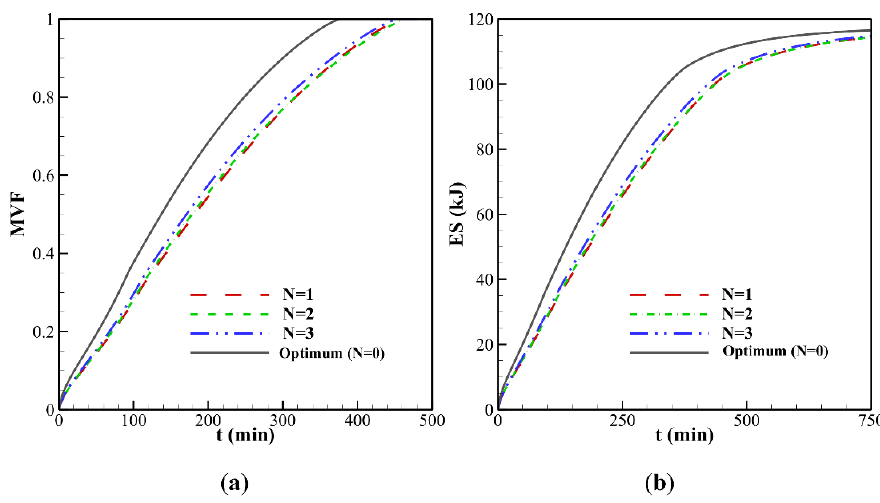
Figure 12. Effect of number of waves ( N ) on the streamlines, ( a ) Case 6 with N = 4 and ω na = 0.06; ( b ) Case 7 with N = 1 and ω na = 0.06.